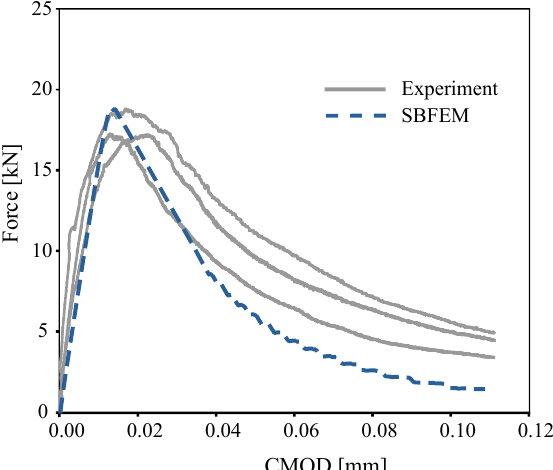
Figure 6. Numerical predictions of load–CMOD curves and the corresponding experimental curves for the single-notched three-point bending test under monotonic